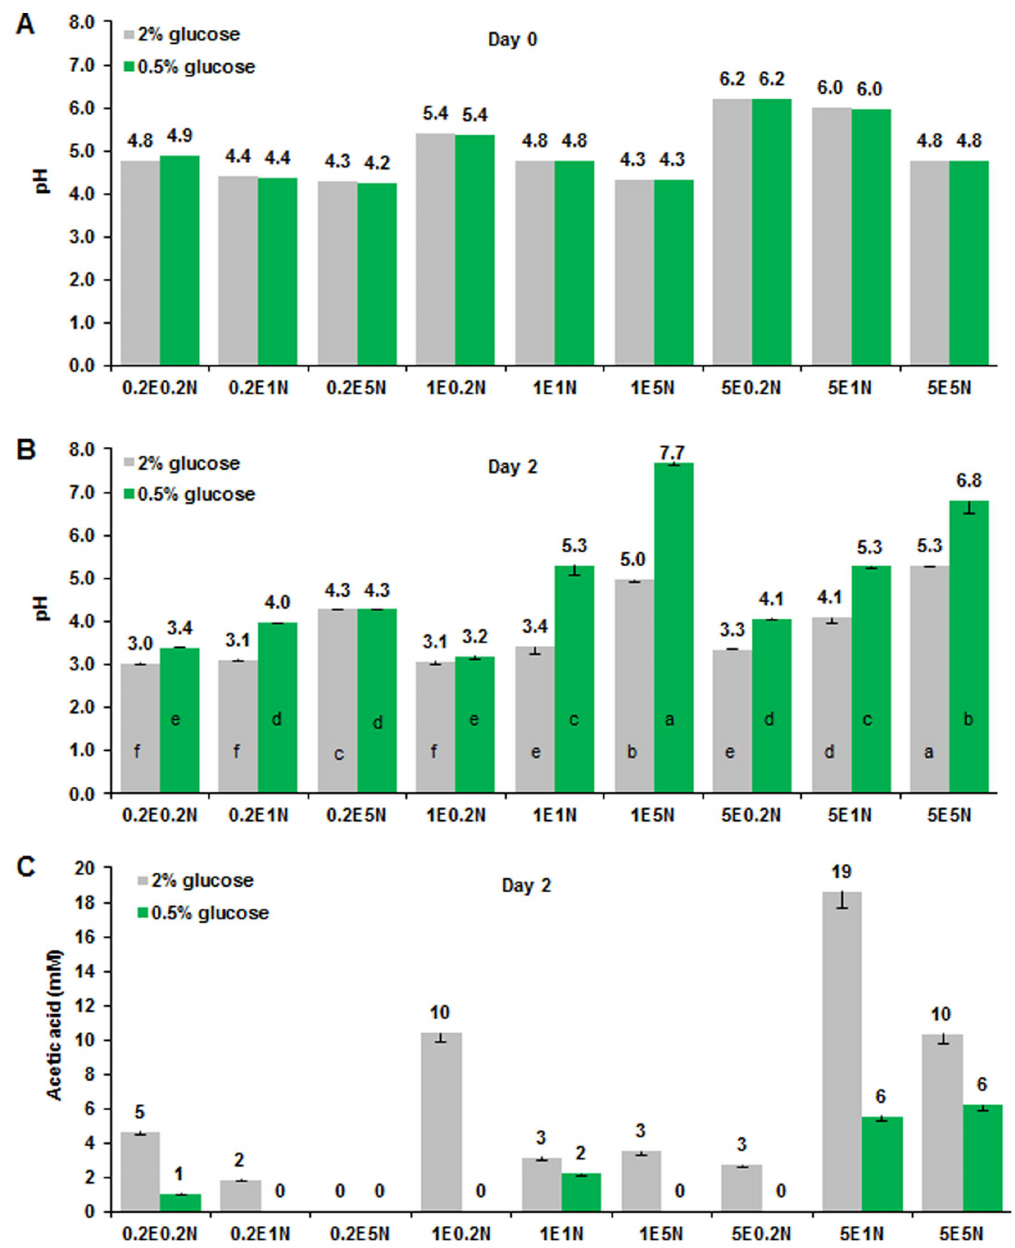
Figure 3. Effects of EAA and NEAA on pH values and acetic acid production of aging media. ( A ) EAA and NEAA composition slightly altered the pH of media. ( B ) The pH of aging media at stationary phase (day 2) was dependent on glucose, EAA and NEAA in media. Differences in means of the pH values of different media under normal or CR conditions, respectively, were analyzed by Duncan’s multiple range test at P , 0.01. ( C ) Acetic acid concentrations in aging media (day 2) was changed by modifications of glucose, EAA and NEAA in media. Datum 0 means not detectable. The pH values of the different fresh media (day 0) were measured once. Acetic acid and pH values (day 2) were expressed as mean 6 s.d. (n=3).